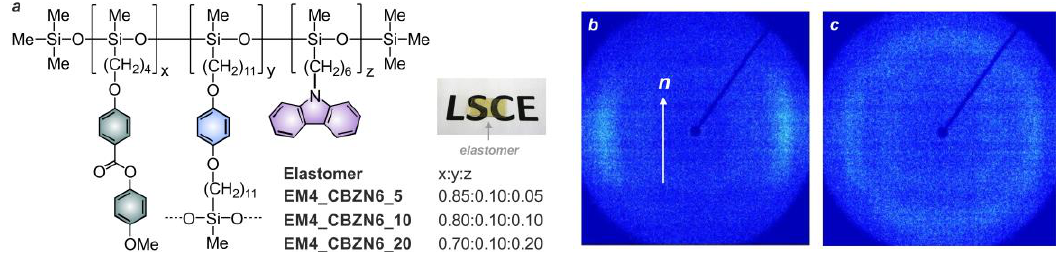
Figure 2. ( a ) Chemical structure of elastomers EM4_CBZN6_5, EM4_CBZN6_10 and EM4_CBZN6_20 and the X-ray di ff raction pattern for elastomers EM4_CBZN6_10 ( b ) and EM4_CBZN6_20 ( c ).